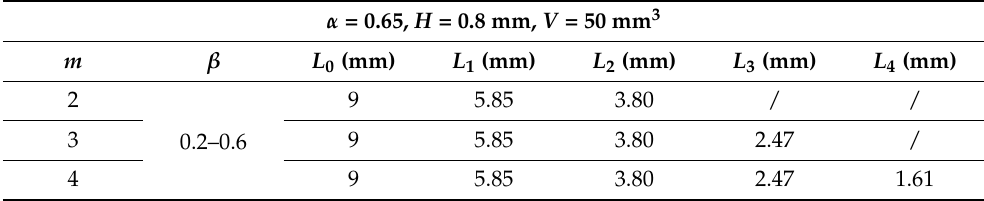
Table 2. Geometric parameters of branched HCM with different m .